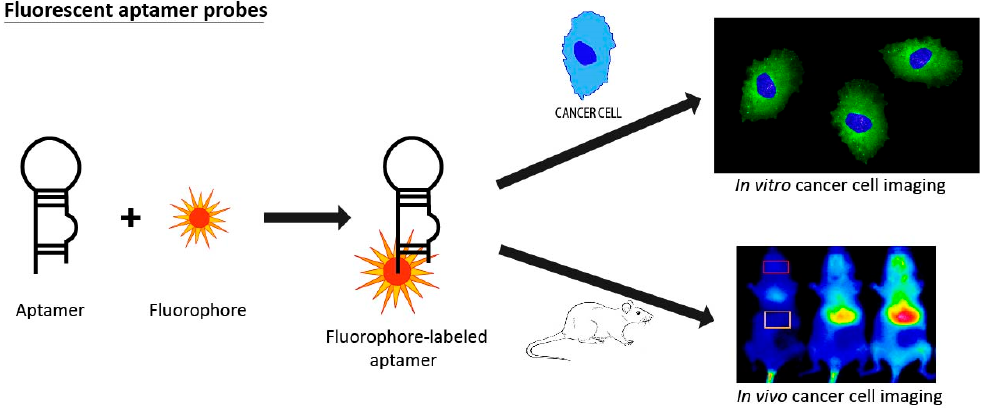
Figure 7. Illustration of fluorescent aptamer probes. The aptamer is labeled with fluorochrome at its 5 ′ end. This chimeric molecule could be used for fluorescence staining of cancer cell as the top image, as well as in vivo cancer cell imaging in tumor-bearing mice, as in the picture beneath.